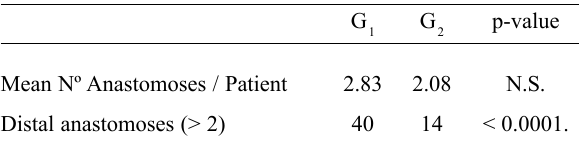
Table 2. Number of anastomoses performed